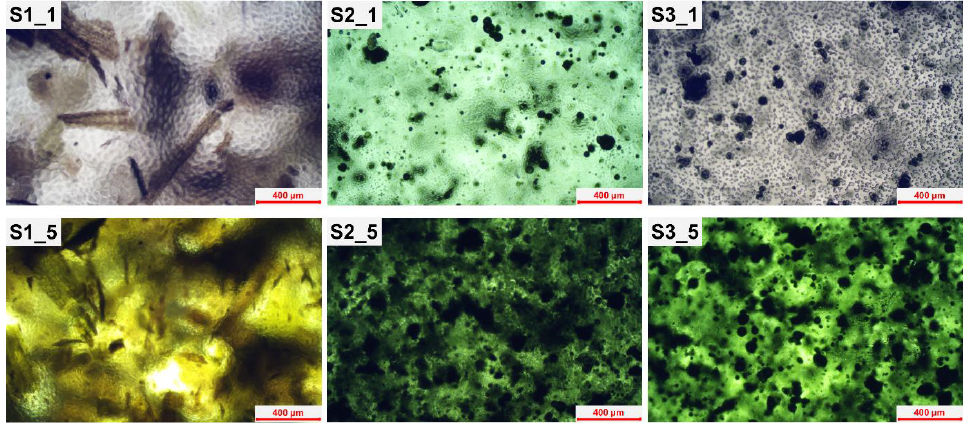
Figure 3. Optical micrograph of algae-TPU-based composites. Series S1 filled with Enteromorpha – Zostera marina blend, series S2 contained Chlorella vulgaris waste — algae after oil extraction and S3 series Chlorella vulgaris before oil extraction.